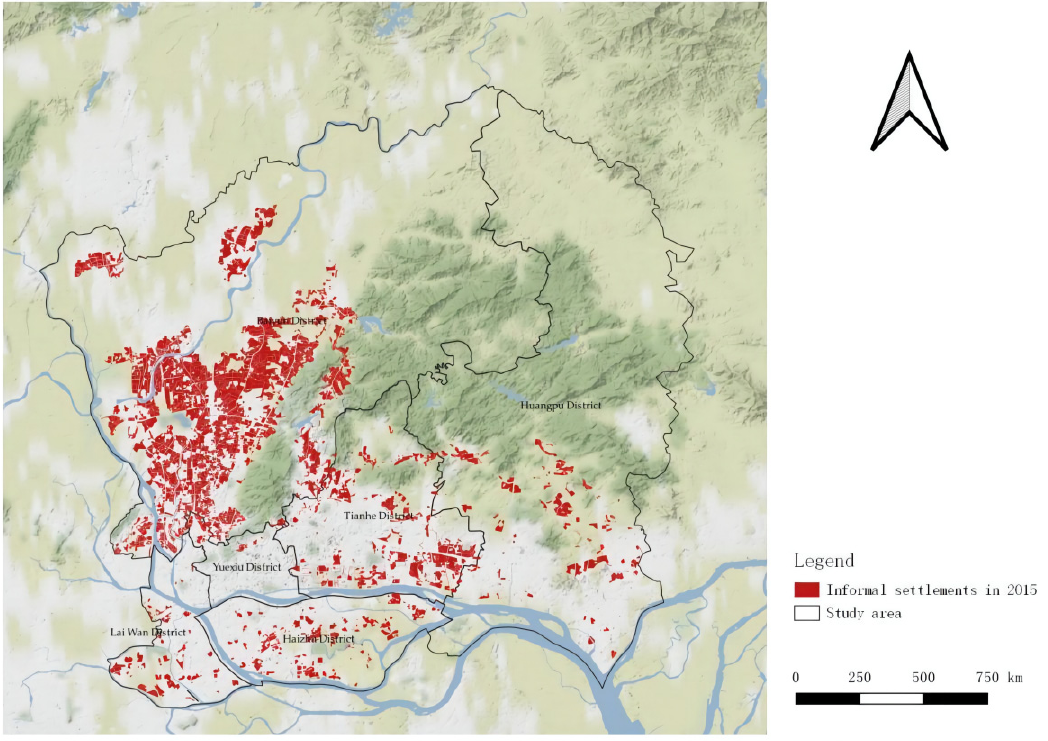
Figure 7. The spatial distribution characteristics of informal settlements in 2015. Source: drawn by the authors.The background image is from Stamen map.